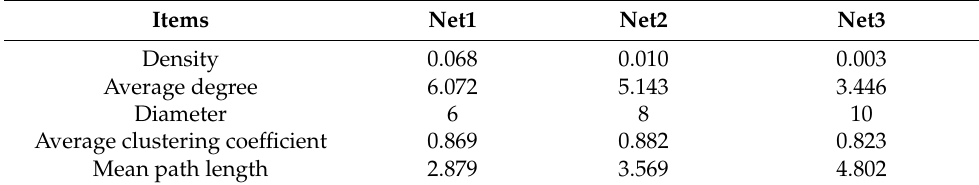
Table 4. Network characteristic